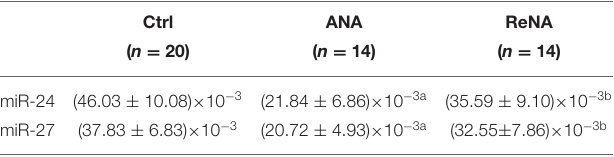
TABLE 1 | Expression of miR-24 and miR-27 in patients with non-atopic INS and healthy controls. Ctrl ANA ReNA ( n = 20) ( n = 14) ( n = 14) miR-24 (46.03 ± 10.08) × 10 − 3 (21.84 ± 6.86) × 10 − 3a (35.59 ± 9.10) × 10 −